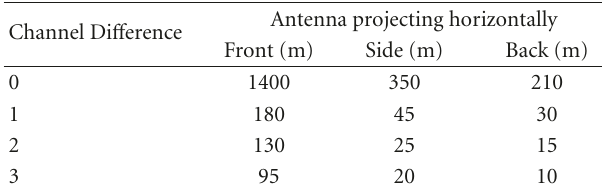
Table 1: Minimum required distance between readers